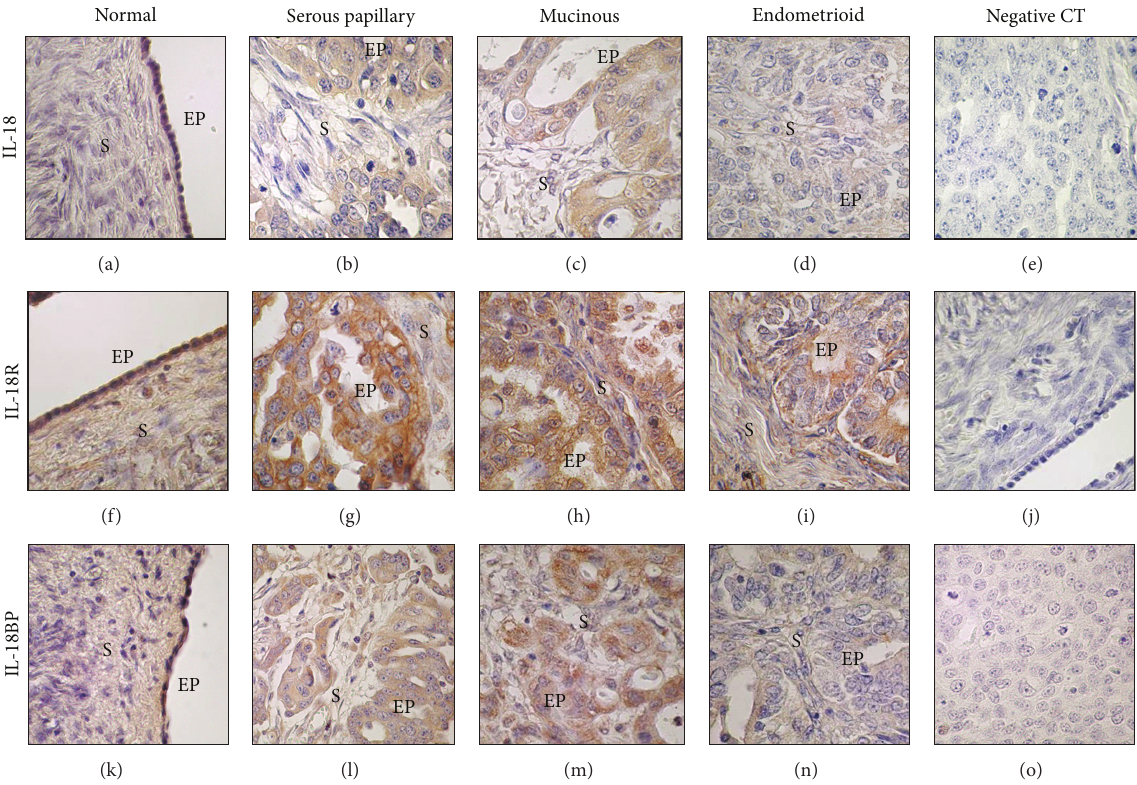
Figure 3: Immunohistochemical staining of normal and cancerous ovarian tissues for IL-18, IL-18R, and IL-18BP. Immunohistochemical staining of normal ((a), (f), (k)) and different types of cancerous ovarian tissues: serous papillary ((b), (g), (l)), mucinous ((c), (h), (m)), and endometrioid ((d), (i), (n)) with mouse anti-human IL-18 ((a)–(d)), mouse anti-human IL-18R ((f)–(i)), and goat anti-human IL-18BP ((k)– (n)) antibodies. Both normal (j) and cancerous ((e), (o)) tissues were used as negative control. EP: epithelial cells and S: stroma. Magnification: ×